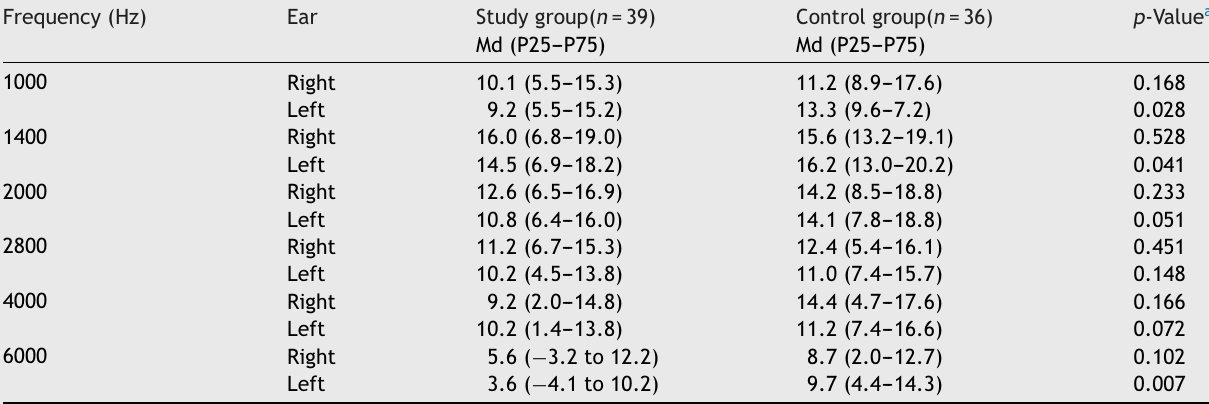
Comparison of amplitudes (dB SPL) of DPOAE between